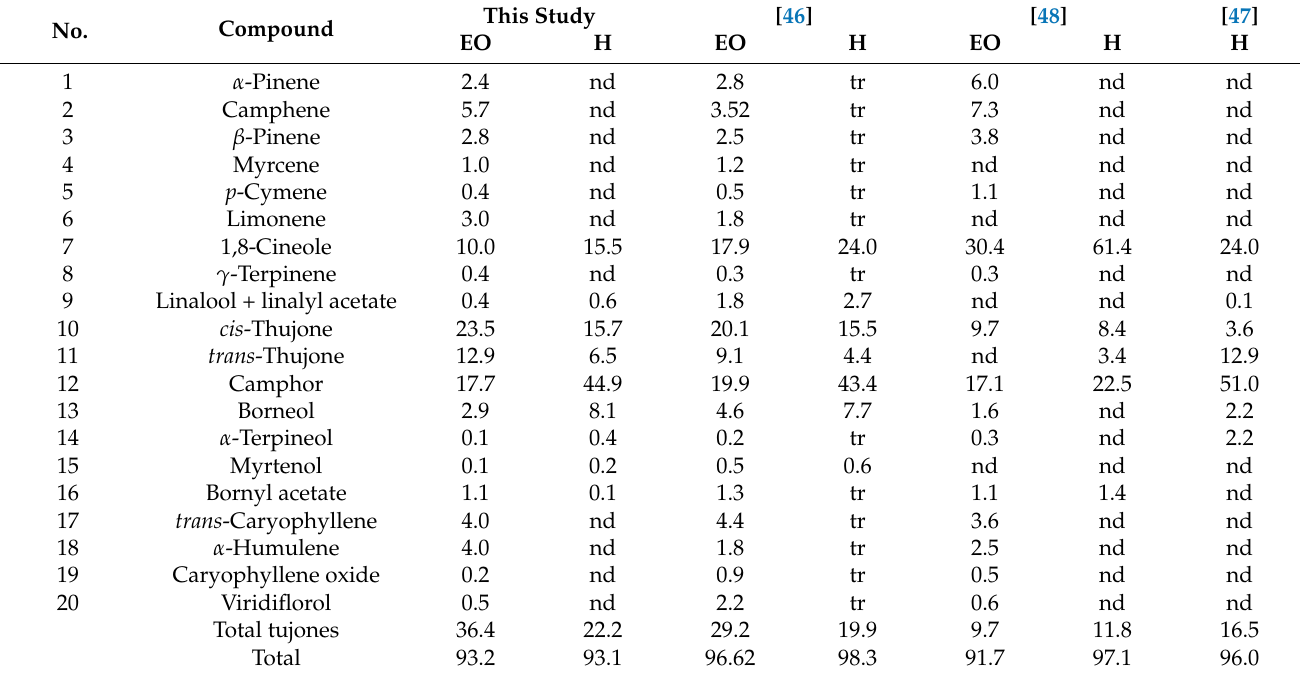
Table 6. Essential oil and hydrolate composition according to this study and